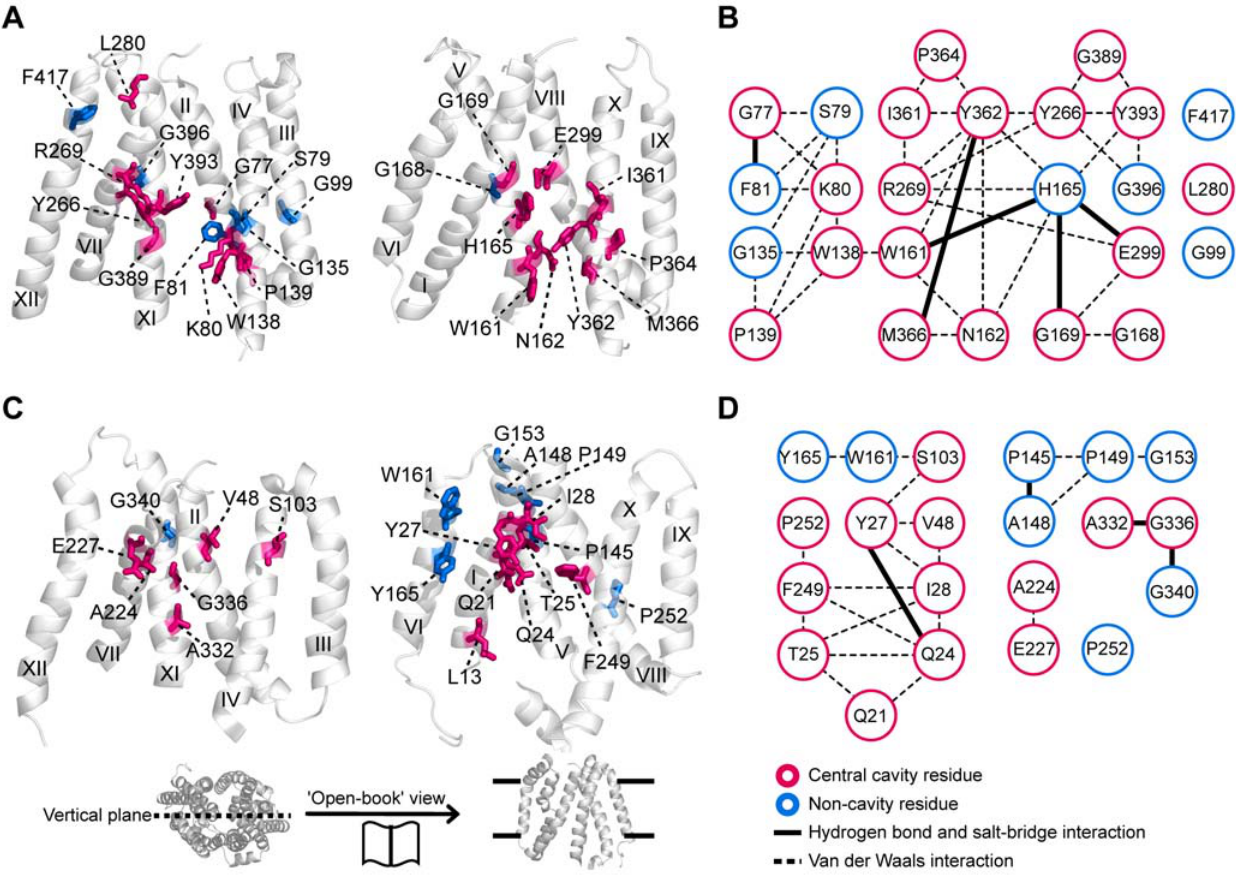
Figure 5. High-IS residues of GlpT and EmrD. (A) ‘Open book’ view of detected residues in GlpT. Central cavity and non-cavity residue are shown in red and blue sticks, respectively. (B) Interaction network of the detected residues in GlpT. Of the 22 network comprising residues (left), 17 residues are found in central cavity (red sticks) and 5 residues are found in the non-cavity region (blue sticks). Dashed line indicates a van der Waals interaction. Bold line indicates a potential hydrogen bond or salt bridge. (C) Mapping high-IS residues onto the EmrD structure. (D) Interaction network of the detected residues of EmrD. Ten residues comprise a main interaction network (left).